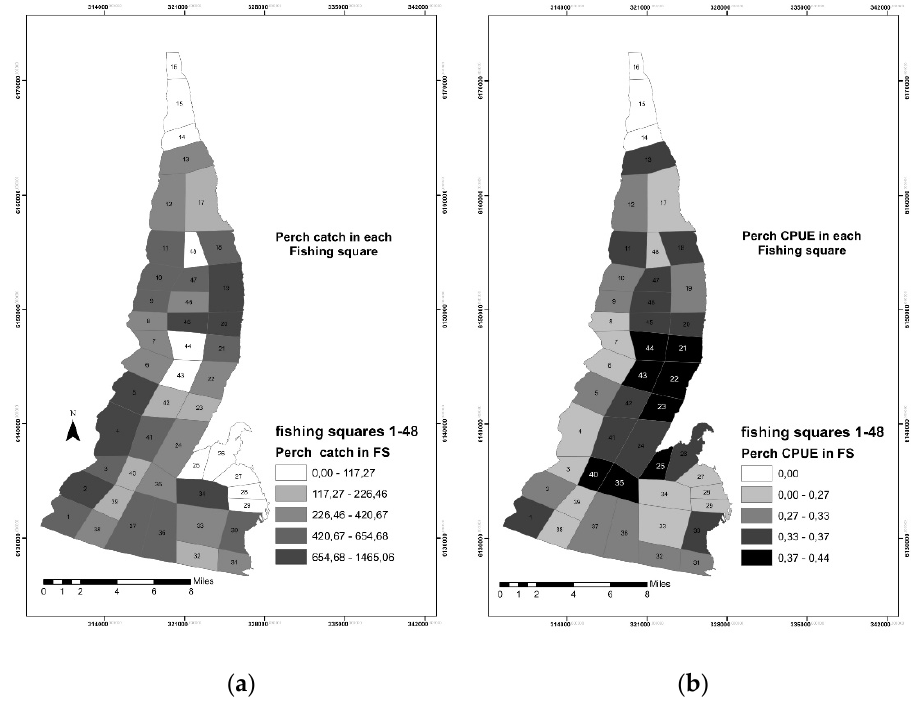
Figure 5. Distribution of perch catches of commercial fisheries in fishing square: ( a ) total catch in each fishing square in kilograms, ( b ) CPUE of perch by the 40–59 mm mesh size gillnets.